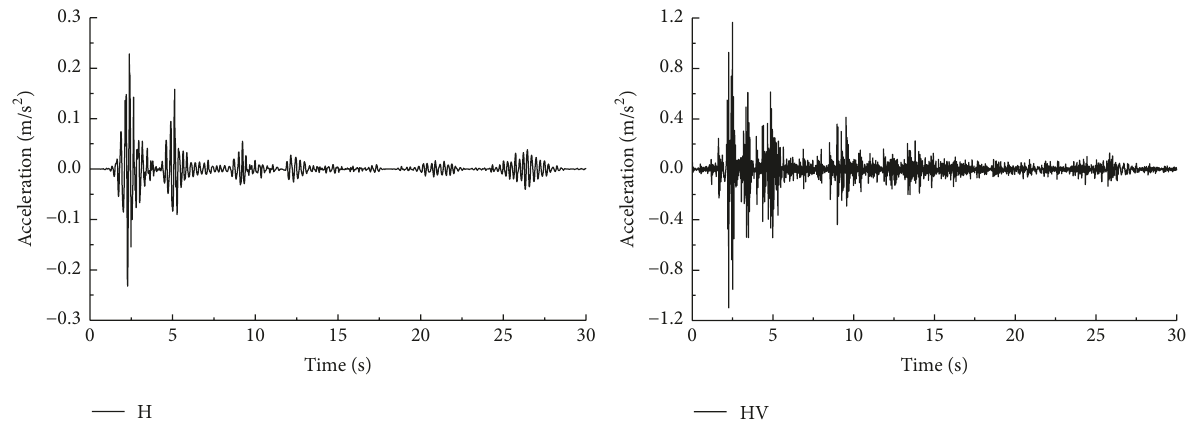
Figure 15: Vertical acceleration time history at node 103 under EL wave for H case and HV case.